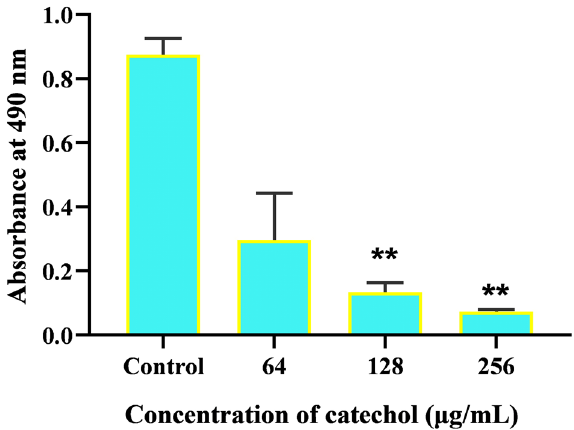
Figure 10. Quantification of total polysaccharide content in C. albicans after grown 24 h with and without catechol using phenol-suphuric acid method. Error bars indicates the mean values of two experimental triplicates. The “* “and “**” symbols represents the statistical significance of p < 0.05 and p < 0.01,